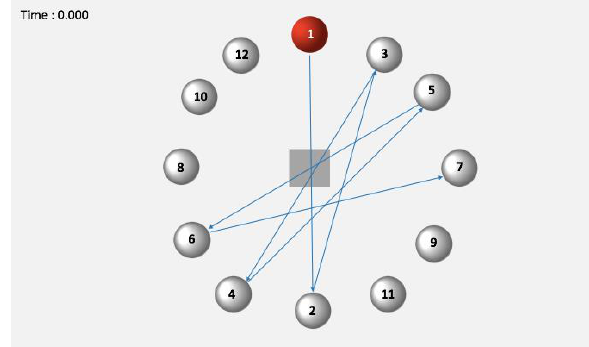
Fig.4. The pointing sequence of the virtual red balls (shown as ball